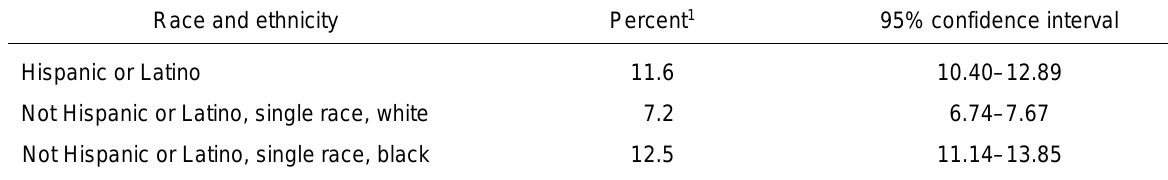
Data table for Figure 14.3. Age-sex-adjusted prevalence of diagnosed diabetes among adults aged 18 and over, by race and ethnicity: United States,